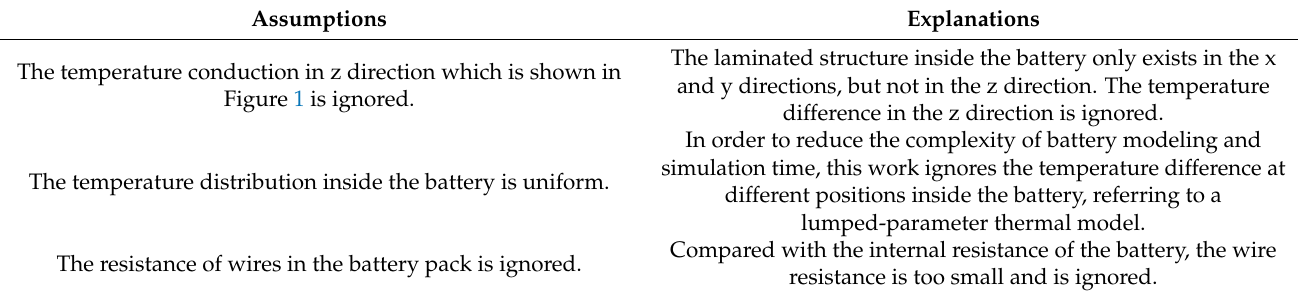
Table 2. Assumptions of the thermal model.